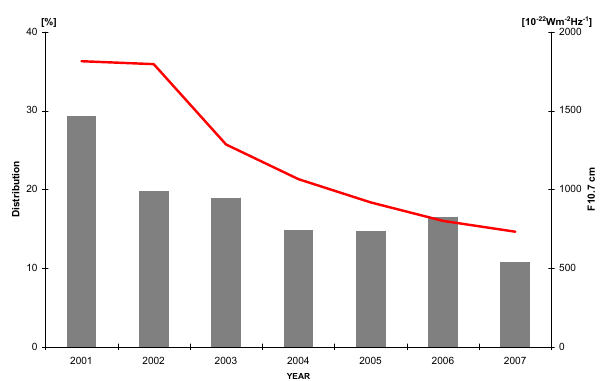
Fig. 5. This figure shows the yearly density histogram of only those measurements which are higher than 0.2cm − 3 . This is overlaid by the red line showing the waning curve of the 10.7cm solar radio flux. A diminishing trend is clearly seen throughout this period which also constitutes the waning part of solar cycle